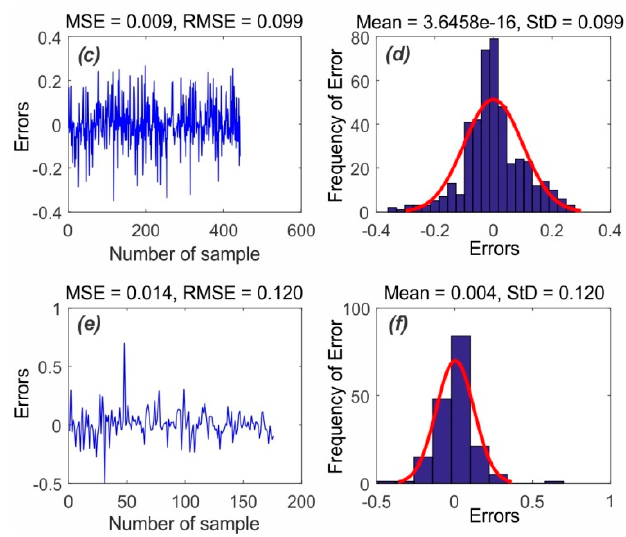
Figure 12. The SWARA-ANFIS-PSO method. ( a ) Target and outputs for the training set; ( b ) target and outputs for the verification set; ( c ) MSE and RMSE for the training set; ( d ) frequency errors for the verification set; ( e ) MSE and RMSE for the verification set; ( f ) frequency errors for the verification set.